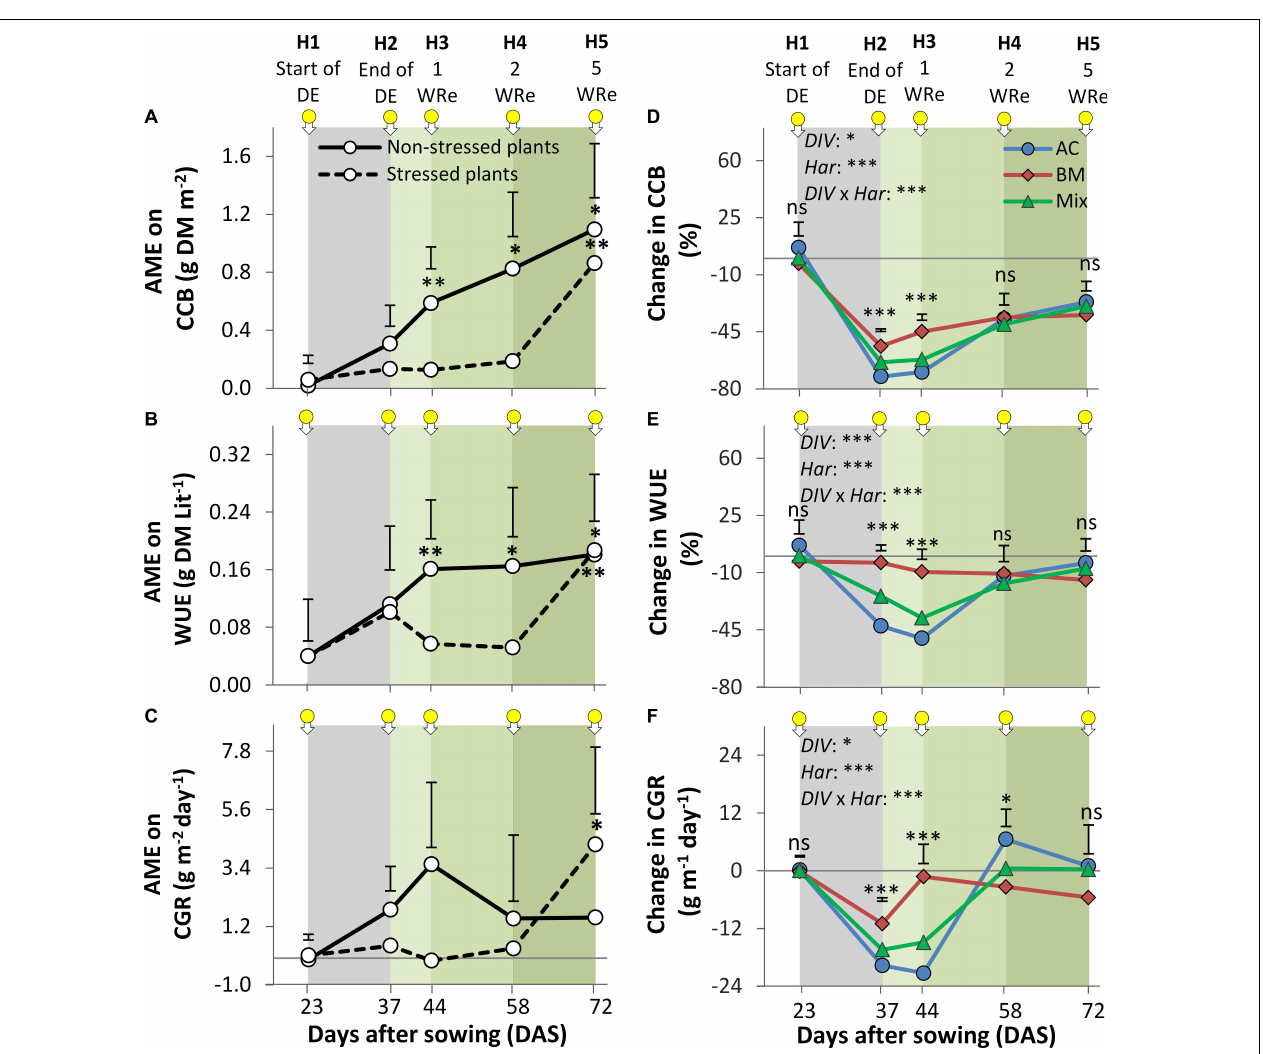
FIGURE 4 | Absolute mixture effect (AME) on cover crop aboveground biomass (CCB; A ), water use efficiency (WUE; B ), and crop growth rate (CGR; C ) of alsike clover (AC), black medic (BM) in monocultures and a 1:1 mixture of the two species (Mix). Mixture effect = the estimated value in mixture – the estimated value in average of monocultures. Positive values indicate positive mixture effect. Change in the CCB (D) , WUE (E) , and CGR (F) (see Equation 5). The plants were harvested at five times indicated by the downward arrows tagged with yellow small circles. The gray shaded area indicates the duration of a drought event and the green gradient color represents weeks of recovery (WRe) after rewatering. In (A–C) , the non-stressed plants and stressed plants are visualized in solid and broken lines, respectively, the vertical bars represent LSD test ( p < 0.05) at a given harvest time ( n = 5) and the asterisks indicate significant mixture effects above 0 according to Welch’s t -test. In (D–F) The vertical bars represent Tukey’s HSD test ( p < 0.05) at a given harvest time ( n = 5). Asterisks above the vertical bars indicate significant differences among the mean of the monocultures and mixture at each harvest time based on one-way ANOVA at P < 0.05. However, asterisks next to the factors DIV , Har , and DIV × Har indicate significant effects based on ANOVA results of the generalized linear model; ∗∗∗ P < 0.001, ∗ P < 0.05, ns, not